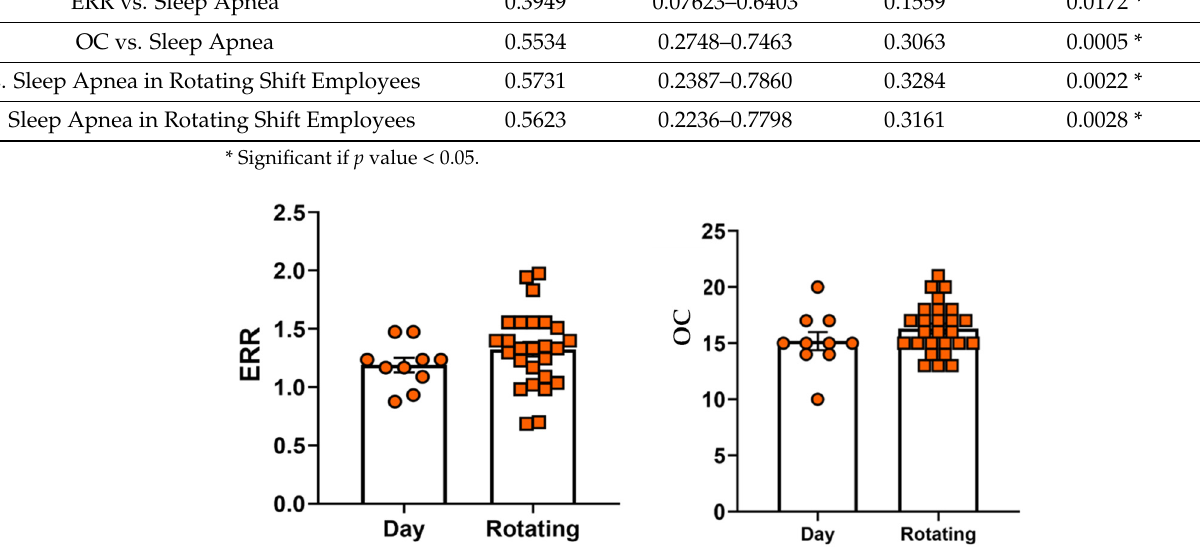
Figure 5. ERR and OC scores were shown in charts with individual data points in day and rotating shift emergency medical service professionals. Table 4. Showing correlation between rotating shift and sleep apnea in participants.